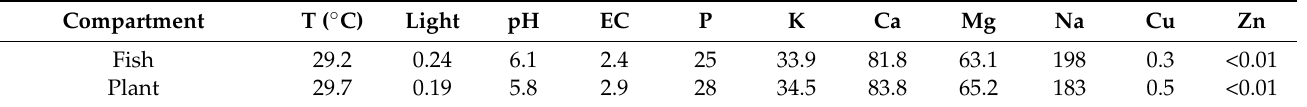
Table 1. Average temperature (T ◦ C), light intensity ( µ mol m − 2 s − 1 ), pH, electrical conductivity (EC, mS m − 1 ), and metal elemental concentration (mg L − 1 ) in the water samples collected from the fish and plant compartments ( n = 3) of the studied aquaponics